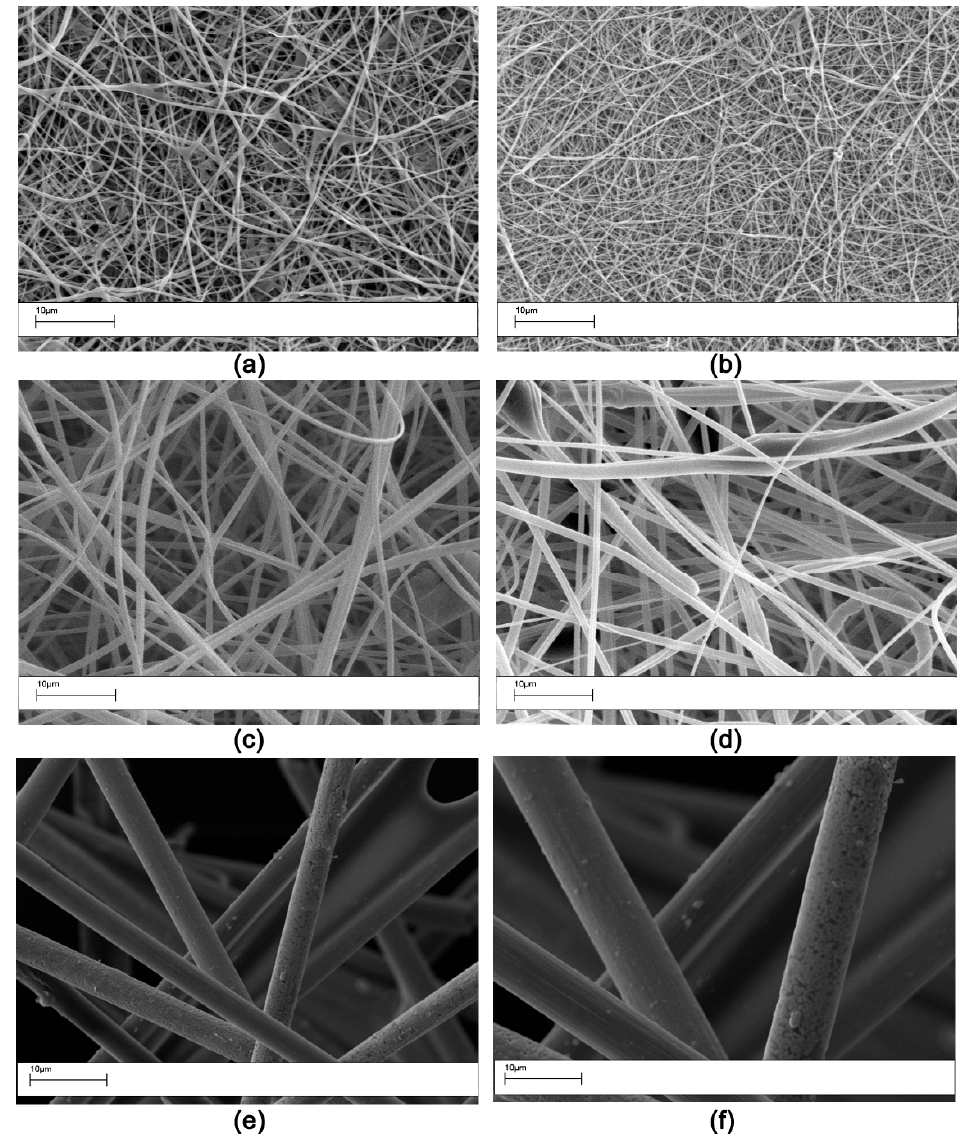
Figure 1. SEM morphology (Magnification 2000×) of the veils used: ( a ) AP1; ( b ) AP2; ( c ) V1; ( d ) V2; ( e ) OV; ( f ) OV with higher Magnification 5000×.